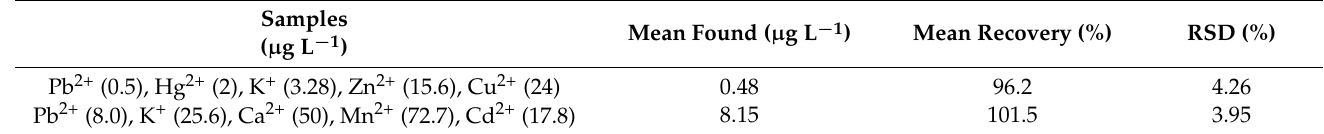
Table 2. Recovery of Pb 2+ from water samples (n = 4) .